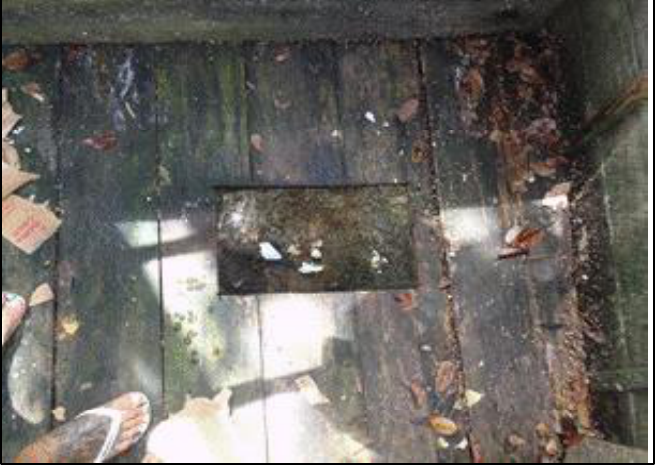
Figura 4: de Banheiro sem Tratamento – PAE Pacajaí I. Fonte: IATAM